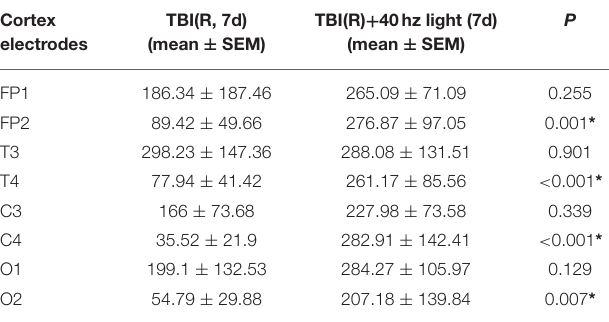
Absoluteenergyofgammaoscillationsforeachcortexelectrodewerecalculated.P-values correspondtoone-wayANOVAbetweenTBI(R,7d)andTBI(R) + 40hzlight(7d)rats.Data are expressed as mean ± SEM. * P < 0.05.